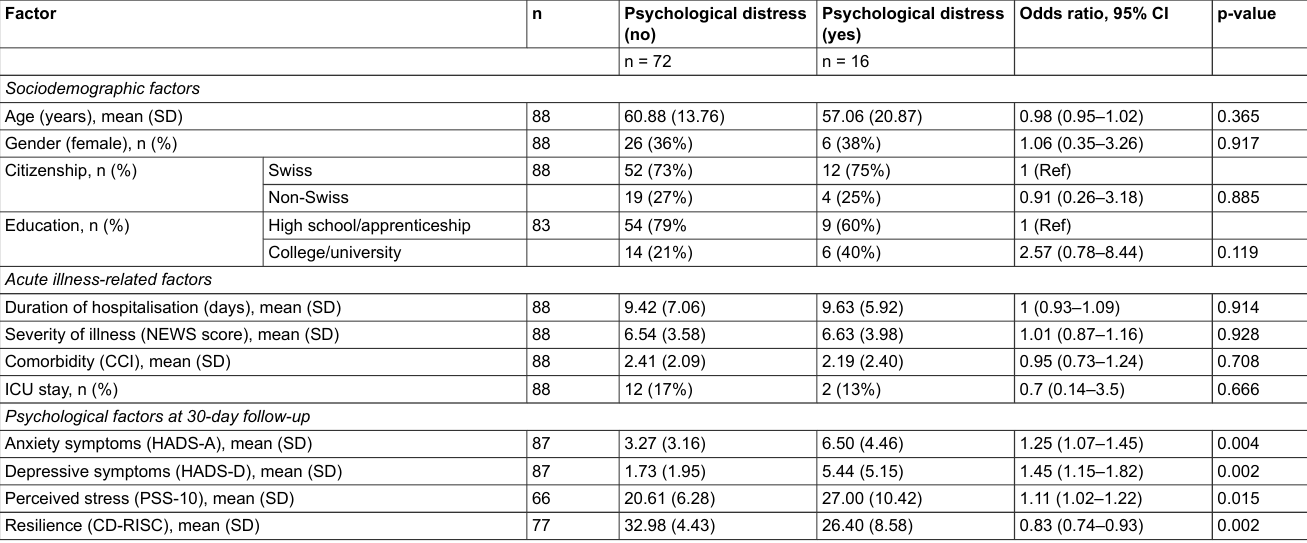
Table 3: Prevalence and factors associated with psychological distress. Factor